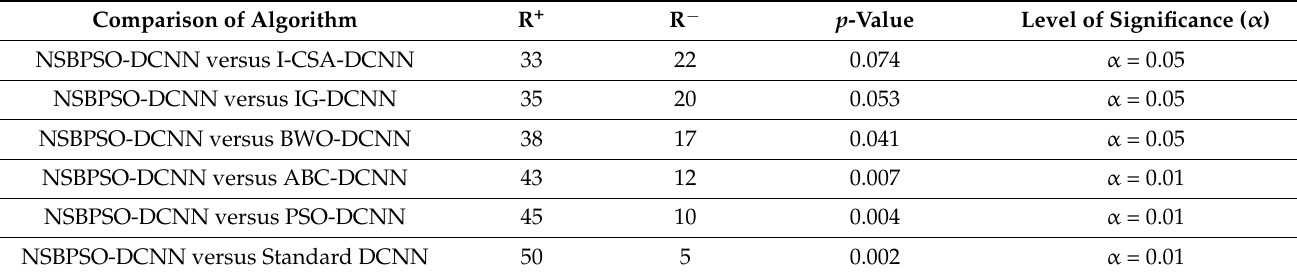
Table 6. The results of architectures in the nonparametric statistical test (Wilcoxon test).